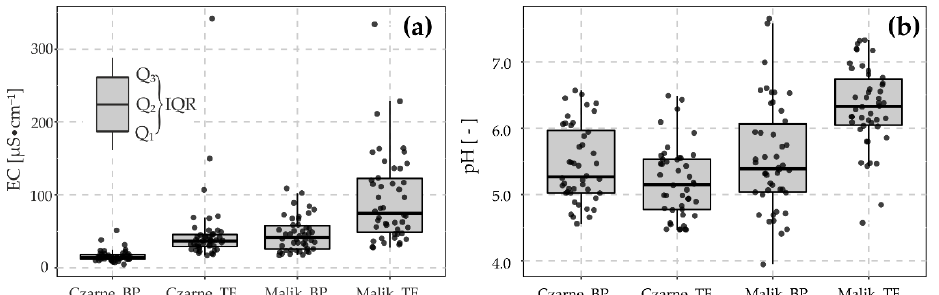
Figure 3. Monthly values of electrical conductivity (EC) ( a ) and pH ( b ) for bulk precipitation (BP) and throughfall (TF). Boxplots indicate the lower quartile (Q1), median (Q2), upper quartile (Q3), and interquartile range (IQR).